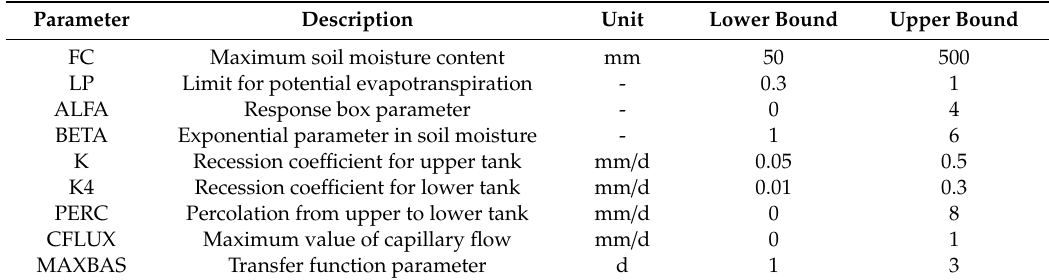
Figure 6. Diagram of Hidrologiska Bryåns Vattenbalansaldevning (HBV) model [50]. Table 3. Description and ranges of parameters in HBV model.